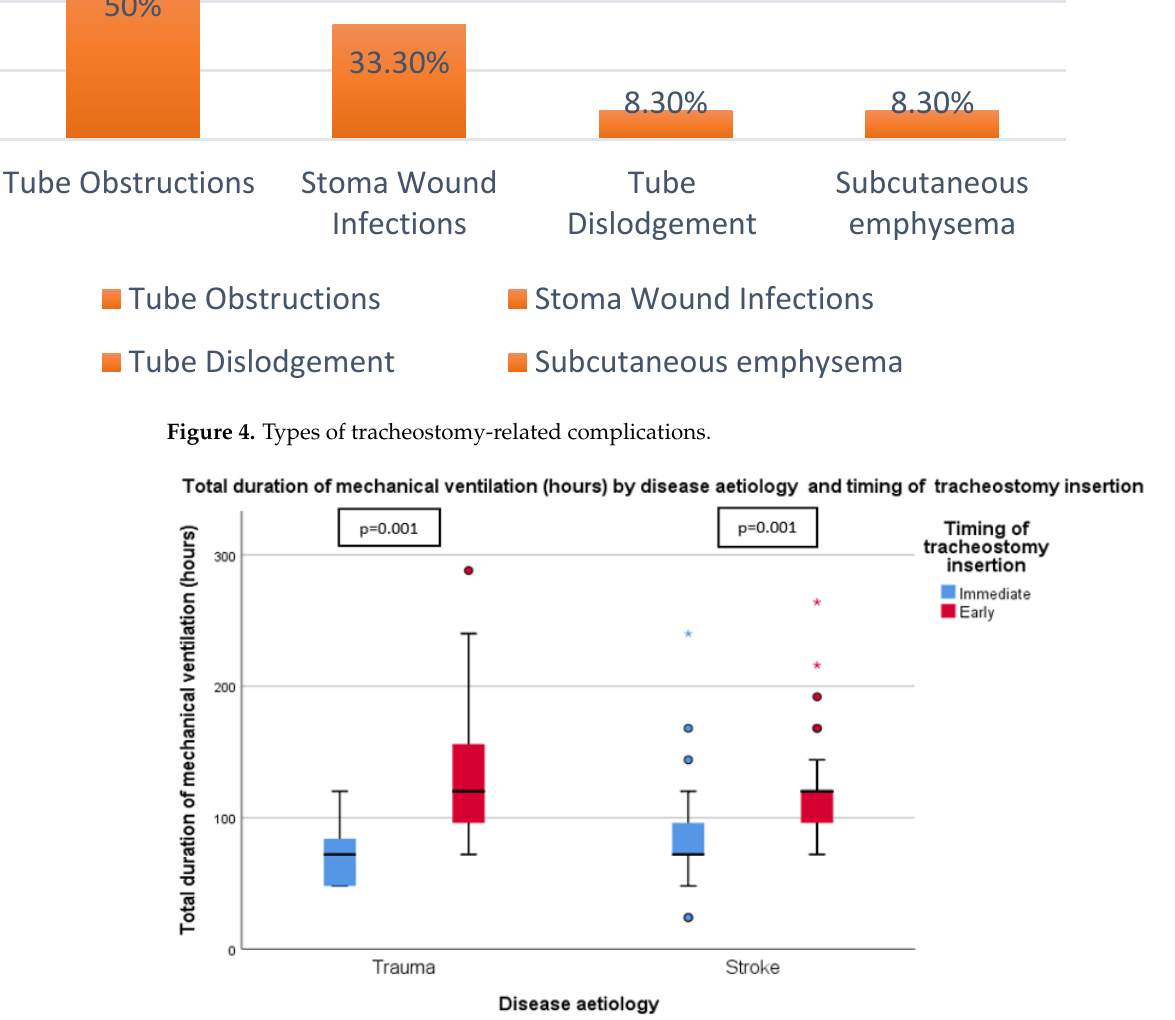
Figure 5. Total duration of mechanical ventilation (hours) by disease aetiology and timing of tracheostomy insertion.